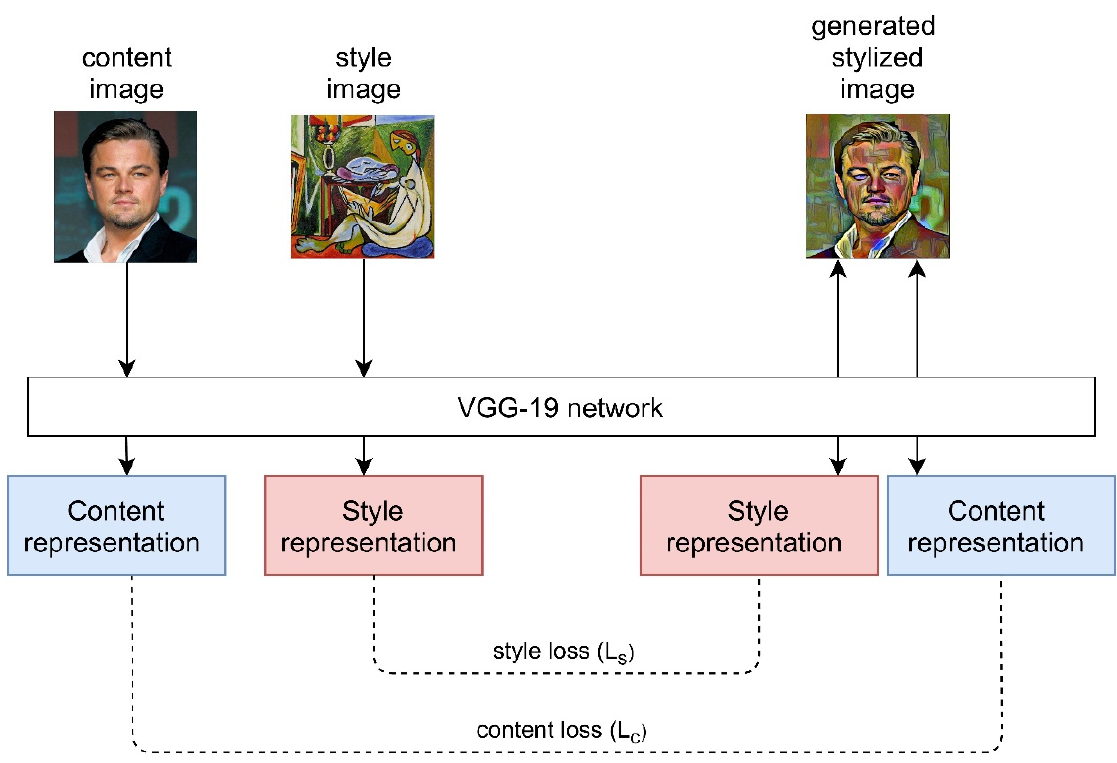
Figure 5. Illustration of concept of neural style transfer using original work [101].